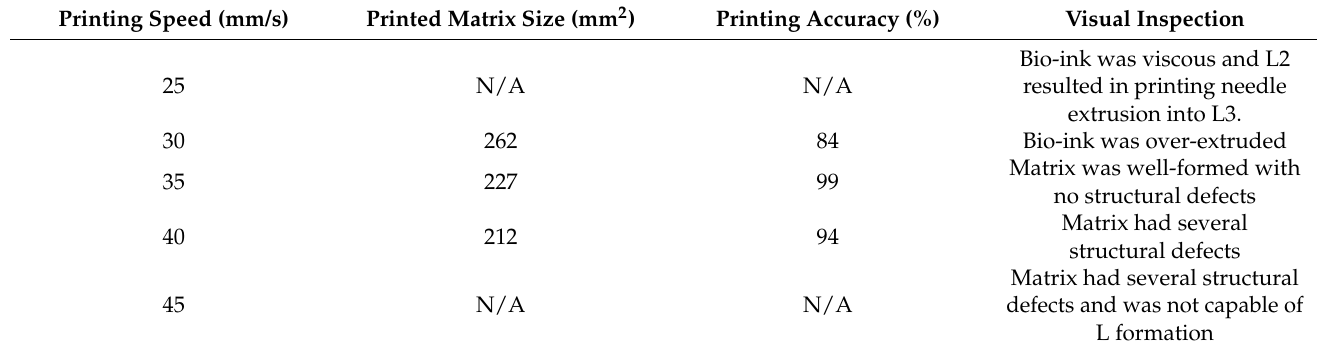
Table 4. Influence of 3D printing speed on printing